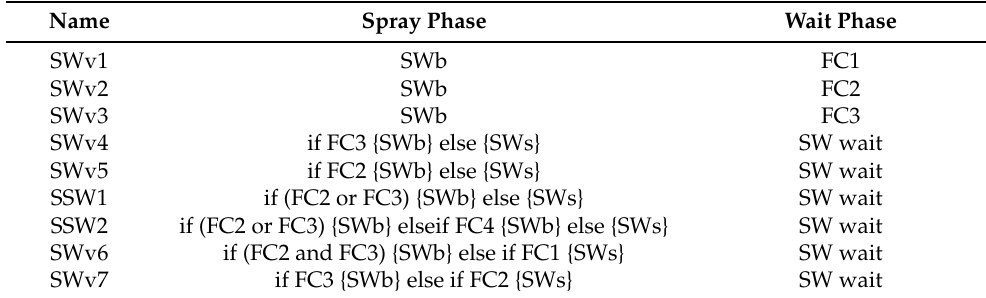
Table 1. Opportunistic algorithm versions.